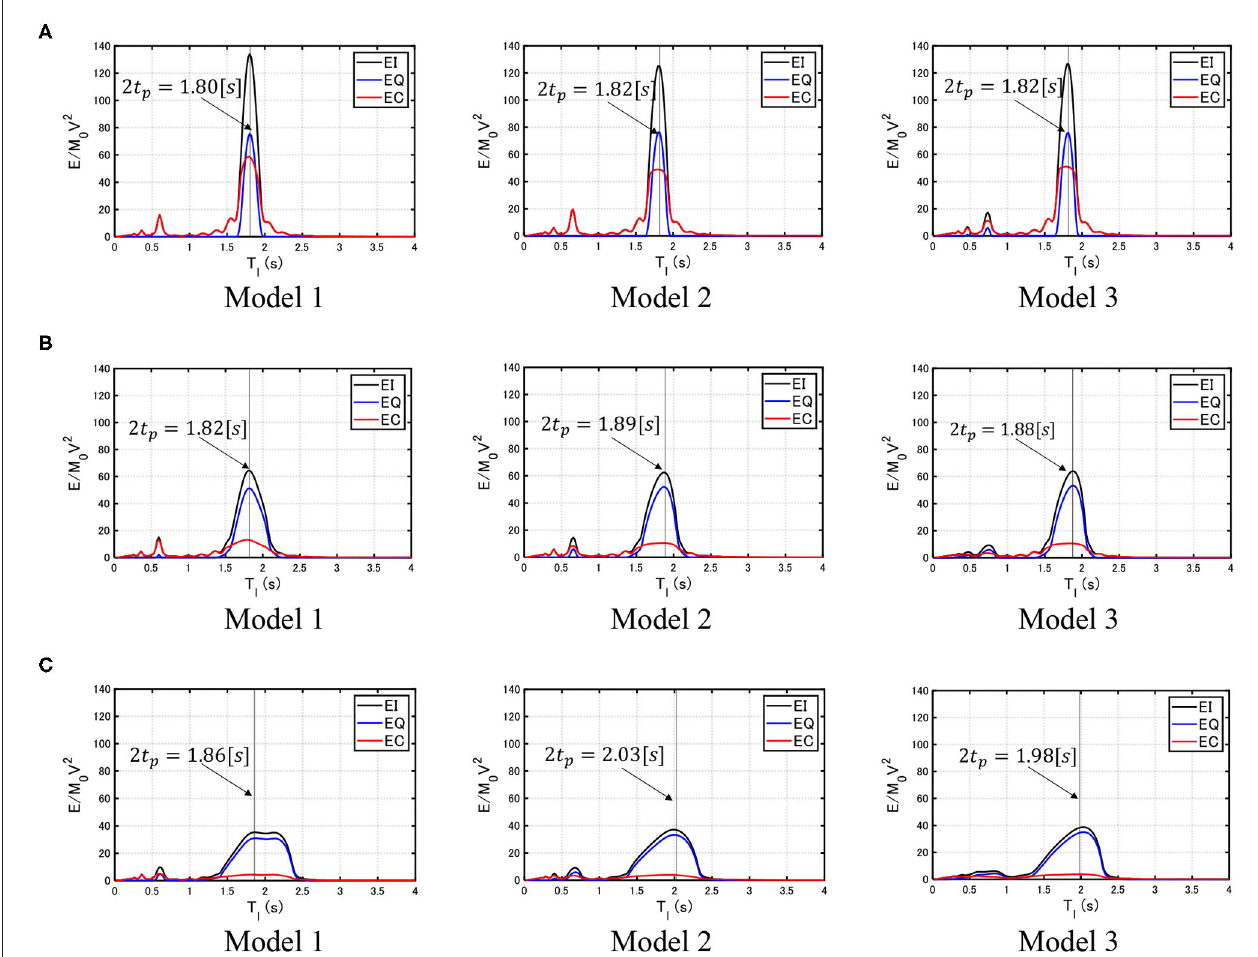
FIGURE 12 | Resonance curve of total input energy, hysteretic energy, and damping energy for elastic–plastic structures. (A) V MI / V y = 2.0, (B) V MI / V y = 5.0, (C) V MI / V y =